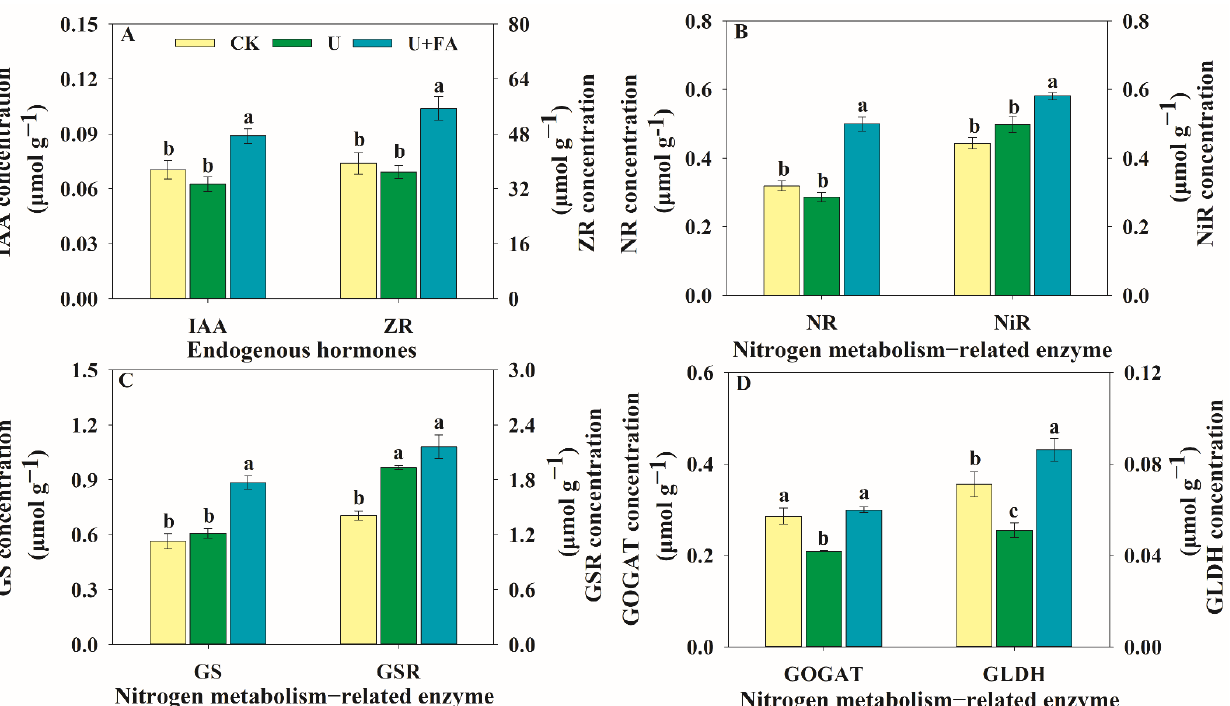
Figure 1. Effects of different fertilization treatments on the endogenous hormones of auxin (IAA, ( A )) and zeatin nucleoside (ZR, ( A )) and the concentrations of nitrogen metabolism-related enzymes of nitrate reductase (NR, ( B) ), nitrite reductase (NiR, ( B )), glutamine synthetase (GS, ( C )), glutathione reductase (GSR, ( C )), glutamate synthase (GOGAT, ( D )), and glutamate dehydrogenase (GLDH, ( D )) in maize root at the 12-leaf stage, in 2018. The treatments include: no nitrogen fertilizer (CK); application of urea (U); combined application of urea and fulvic acid solution (U+FA). The values are means of four replicates, and the error bars are standard errors. Different letters indicate significant differences between treatments for a same parameter according to SNK’s test at p < 0.05.